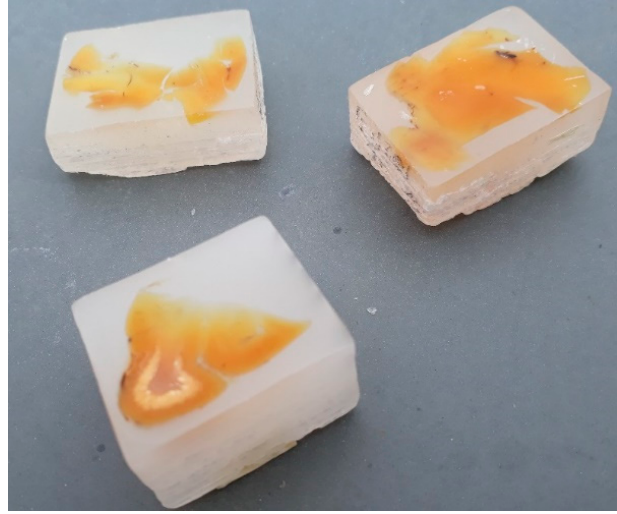
Figure 1. Formalin-fixed paraffin-embedded brain tissue specimens from patients with postenceph- alitic parkinsonism.